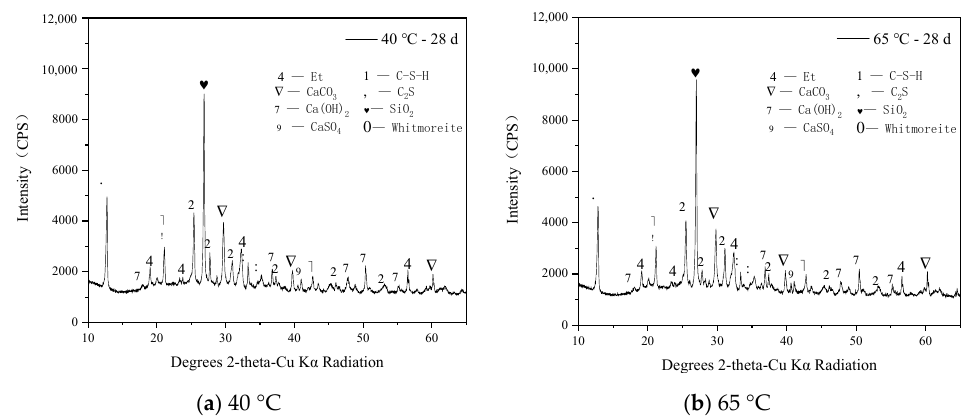
Figure 10. The effect of different curing temperatures on the XRD at 28 d.